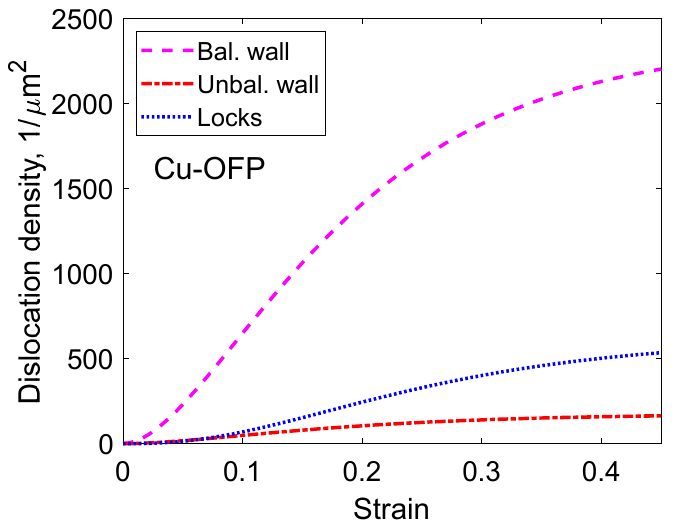
Figure 9. Densities of balanced, unbalanced, and lock dislocations in the cell boundaries as a function of strain for Cu-OFP. Redrawn with permission from ref. [16]. Copyright 2022 Elsevier.